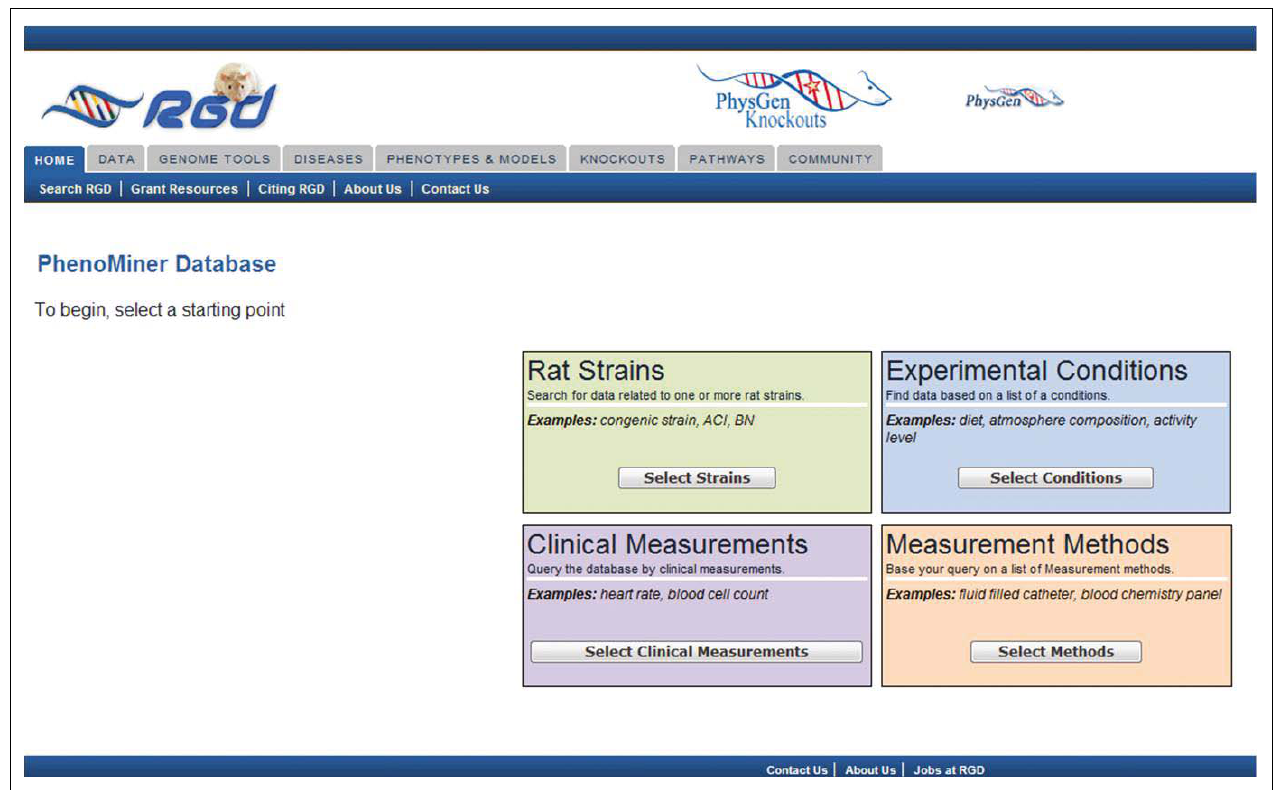
FIGURE 6 |The PhenoMiner